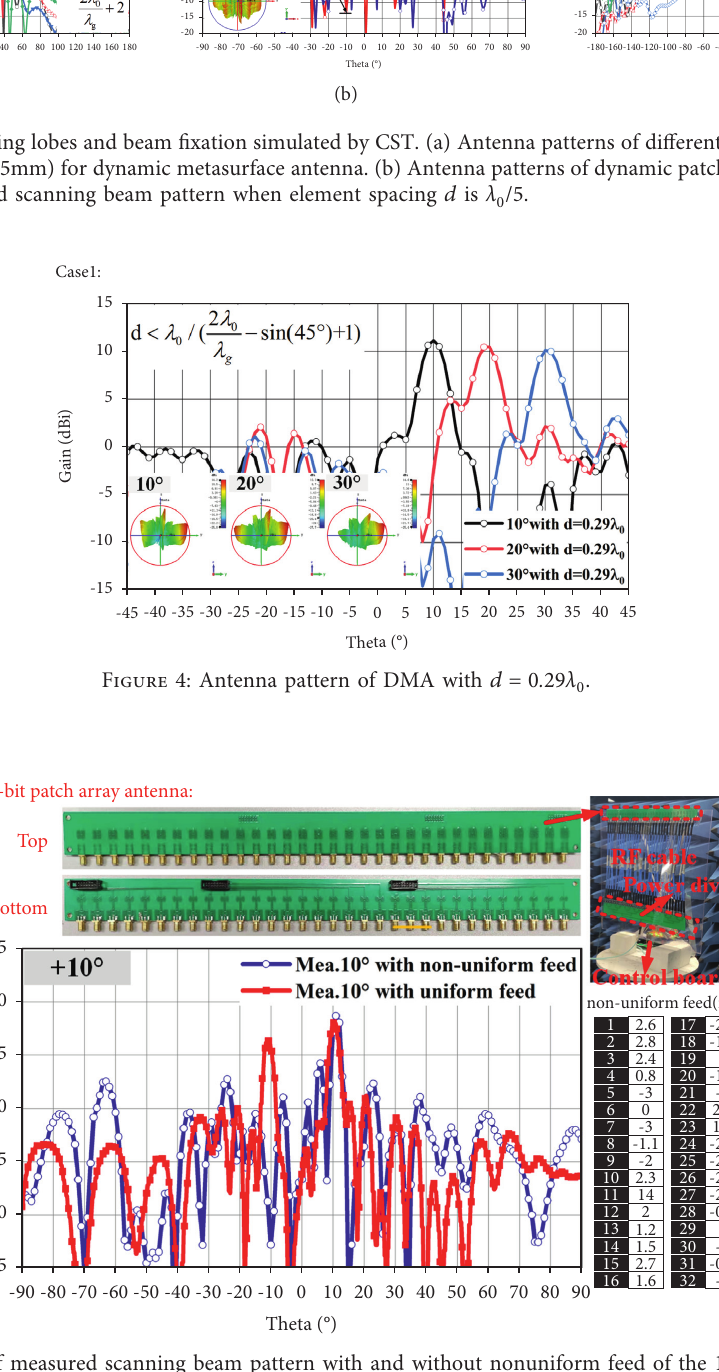
Figure 5: Comparison of measured scanning beam pattern with and without nonuniform feed of the 1-D patch array at 10 °